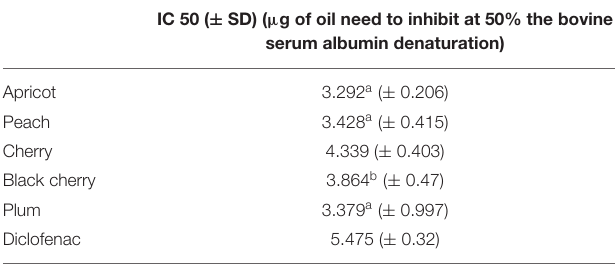
TABLE 4 | Potential anti-inflammatory activity exhibited by the cold-pressed seed oils of apricot, peach, cherry, black cherry, and plum, assessed through the capacity of the oils to inhibit the denaturation of the bovine serum albumin